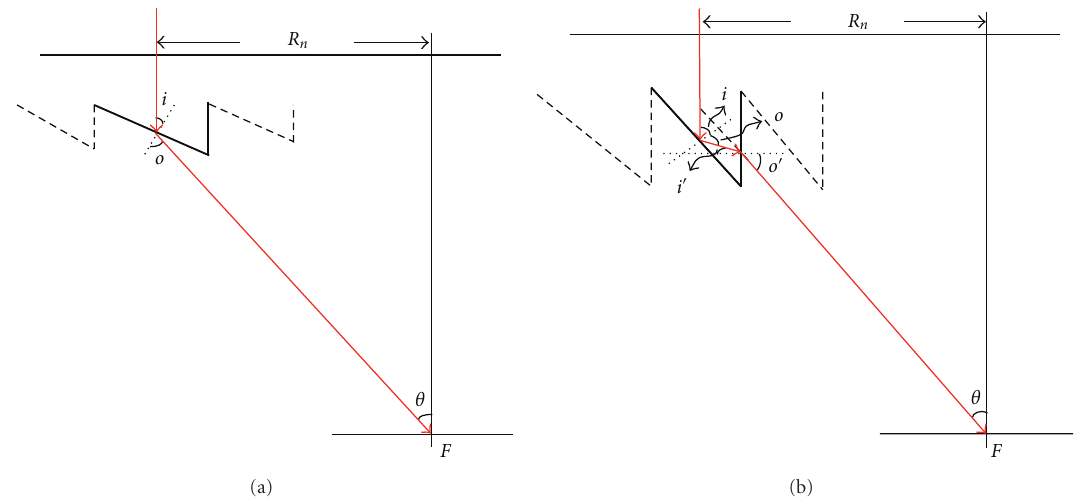
Figure 2: Determination of the critical radius. (a) The direct refractive sawtooth. (b) The TIR sawtooth. The sawteeth and the angle of incident ray are locally exaggerated, only for interpreting conveniently.